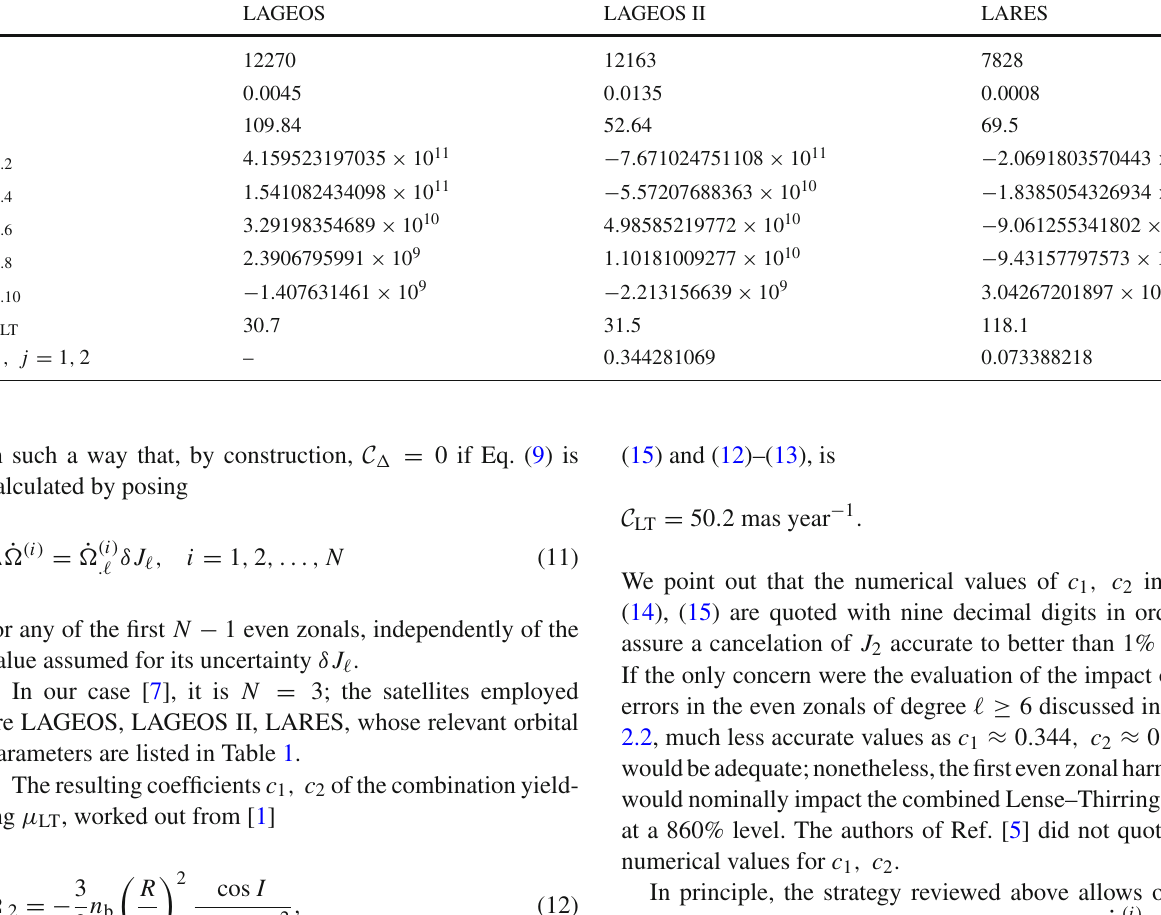
expressed to an accuracy of 0 . 1 mas year − 1 which corresponds to about a percent fraction of the predicted Lense–Thirring combined signa- ture